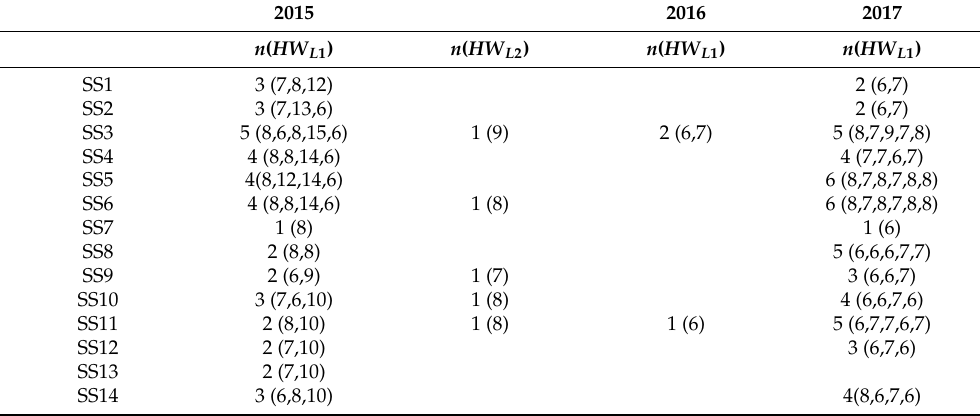
Table 3. Heat Waves (in parenthesis, the length of each HW expressed in days). Legend: n ( HW L 1 ) = number of Heat Waves of the first level; n ( HW L 2 ) = number of Heat Waves of the second